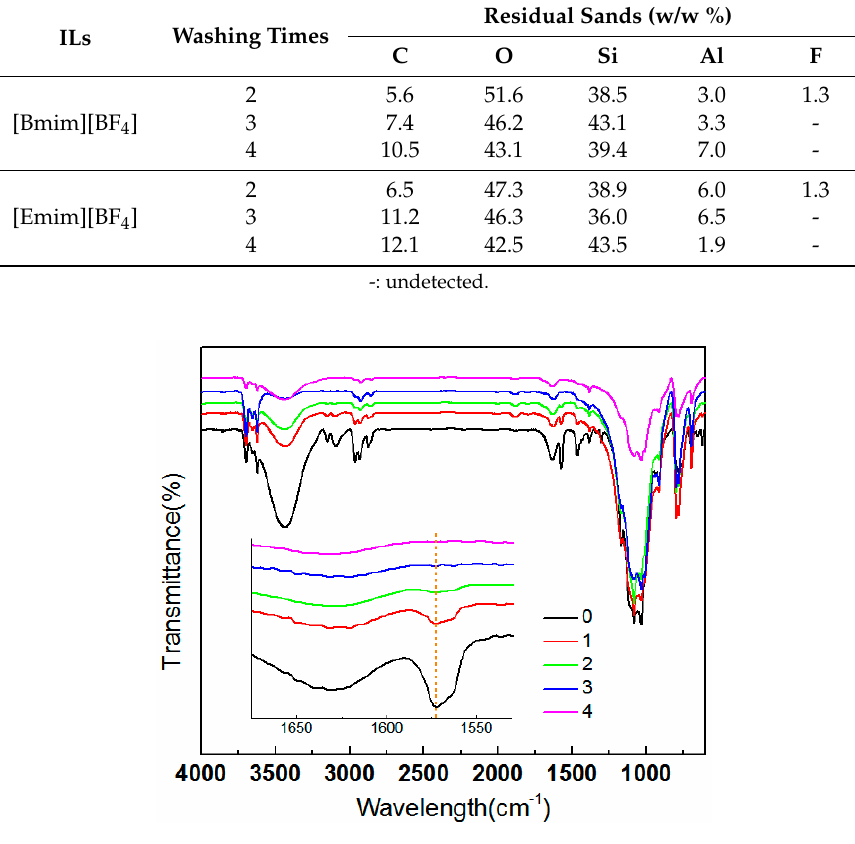
Figure 3. Infrared spectrum of the residual sands with different water washing times after ionic liquid ([Bmim][BF 4 ])-enhanced oil sands extraction.